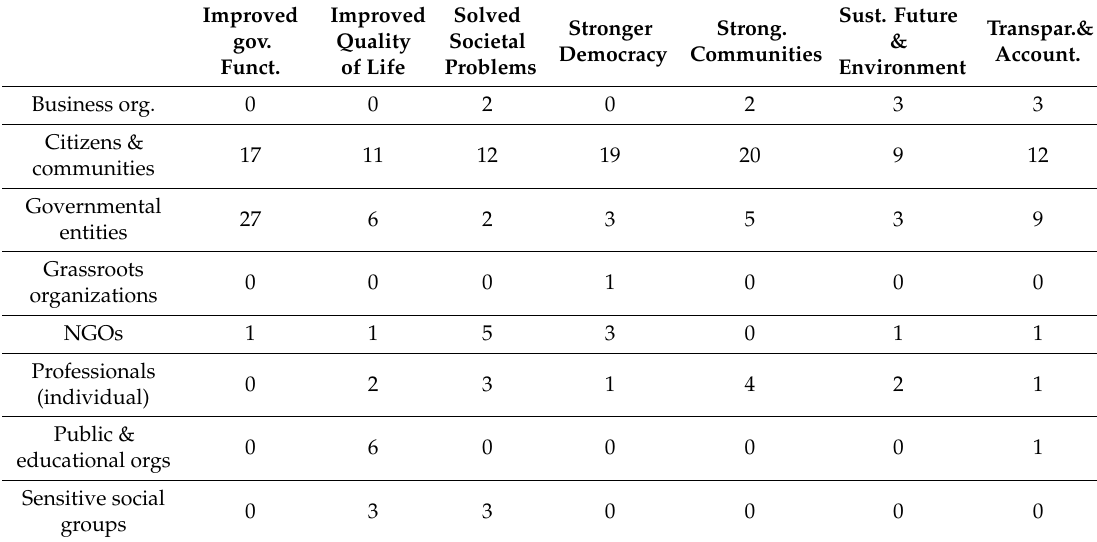
Table 5. The Distribution of Platforms in the Sample based on Target Group and Goals Dimensions.